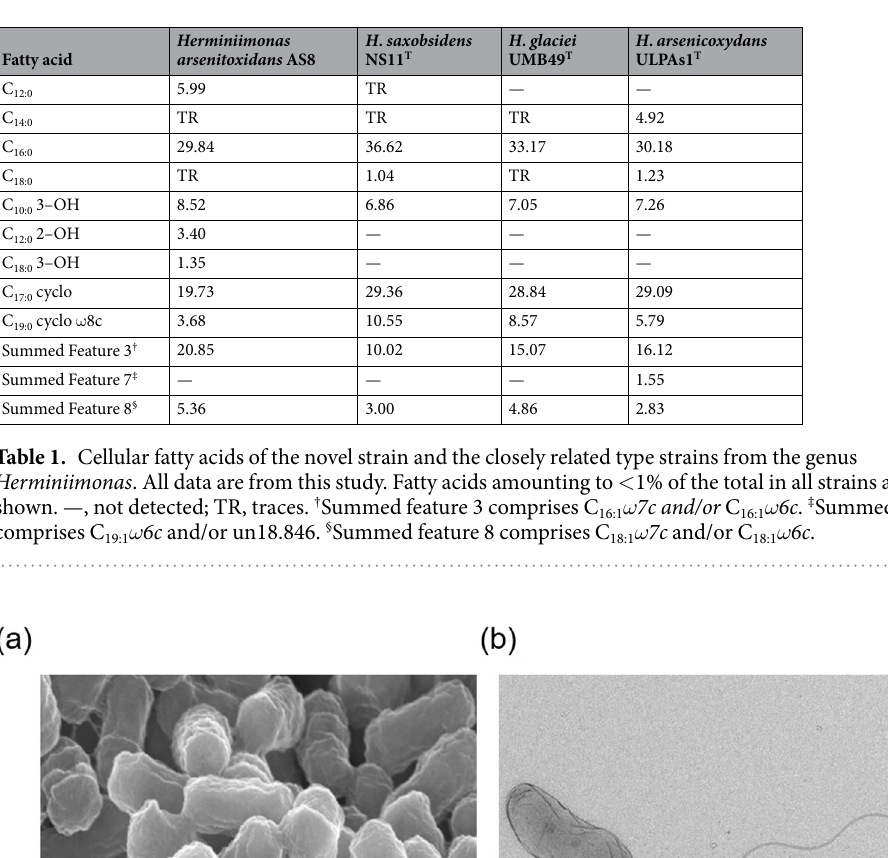
Herminiimonas . The fatty acid profile of AS8 was consistent with that of the reference strains, as shown in Table 1, except that C 12:0 2-OH and C 18:0 3-OH were only present in AS8. Q-8 was the major ubiquinone. The polar lipids included diphosphatidylglycerol (DPG), phosphatidylethanolamine (PE), phosphatidylglycerol (PG), phosphati- dylserine (PS), amino lipid (AL), and five unidentified lipids (ULs) (Supplementary Fig. S2). Furthermore, the AS8 cells were Gram-negative, oxidase- and catalase-positive, motile, aerobic, and rod-shaped, with a single polar flagellum (0.3–0.4 μ m × 0.8–1.0 μ m; Fig. 2). The colonies were beige-pigmented, circular, and smooth, with a diameter of 1.0–1.5 mm after 4 d of growth at 30 °C on R2A agar plates. The maximum growth rate ( μ max) and the specific growth rate ( μ ) of the isolate were estimated as ca. 0.05 and 0.08, respectively, based on the optical density measurements at 600 nm (OD 600 ) (Supplementary Fig. S3a). The tolerable and optimal growing condi- tions for AS8 were as follows: 20–40 °C (optimum: 25–30 °C), pH 3.0–9.0 (optimum: pH 5.0–6.0), and 0–1% (w/v) NaCl (optimum: 0.2–0.4% NaCl). In addition, the isolate oxidized thiosulfate (1 mM) and completely converted arsenite to arsenate (up to 10 mM, growth resistance up to 12 mM). However, the growth rate ( μ max) tended to decrease with the increasing arsenite concentration (Supplementary Fig. S3b). Moreover, the strain tolerated high concentrations of arsenate (up to 80 mM; Supplementary Fig. S3c). Also, strain AS8 exhibited resistance to various other heavy metals, including Cu(II) ( < 5 mM), Pb(II) ( < 10 mM), Cd(II) ( < 10 mM), Co(II) ( < 10 mM), and Zn(II) ( < 10 mM). No growth was observed when arsenite was the sole energy source in the absence of growth factors, including yeast extract. Additionally, the biomass did not change under high-nutrient culture conditions (e.g., tryptic soy or nutrient agar). These results indicated that AS8 might experience energy stress under high-nutrient conditions or might have higher affinity for substrates in nutrient-limited environments. The physiological and biological characteristics of AS8 in comparison with Herminiimonas reference strains are summarized in Table 2.